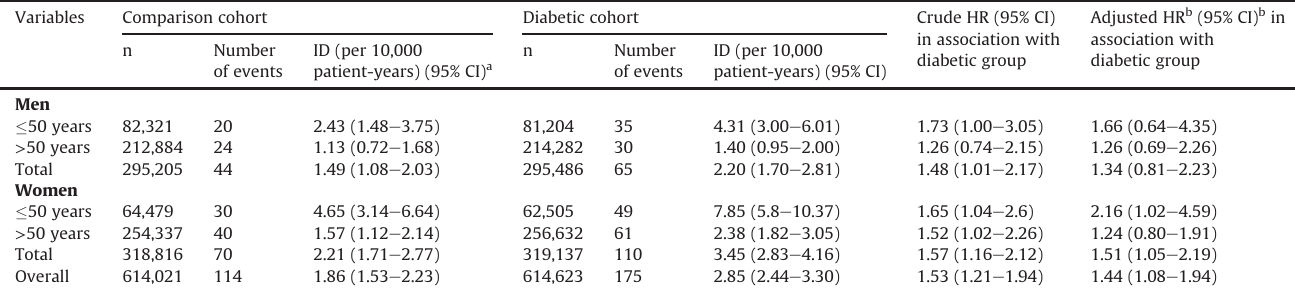
Adjusted HR b (95% CI) b in in association with association with diabetic group diabetic